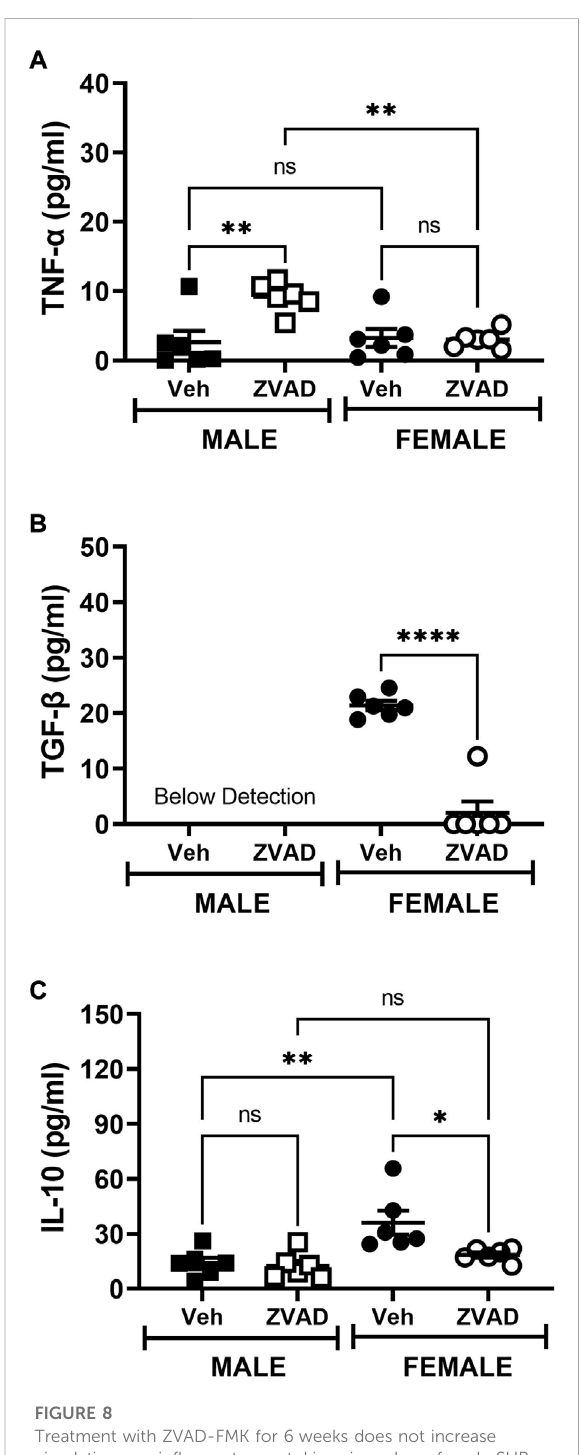
FIGURE 8 Treatment with ZVAD-FMK for 6 weeks does not increase circulating pro-in fl ammatory cytokines in male or female SHR. Circulating levels of TNF- α [panel (A) ], TGF- β [panel (B) ], and IL-10 [panel (C) ] were measured by ELISA in the plasma isolated from male and female spontaneously hypertensive rats